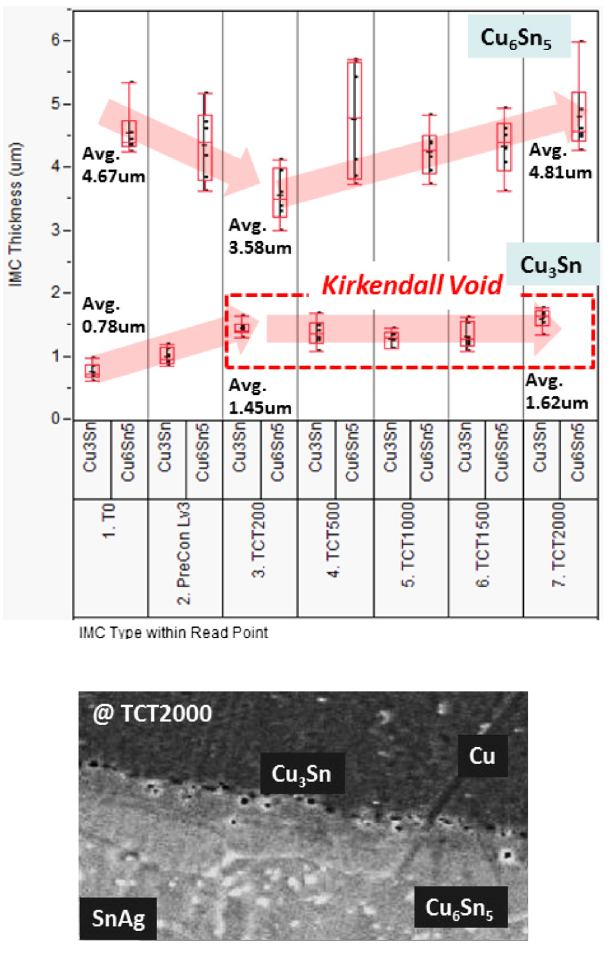
Figure 8. Zoom in section